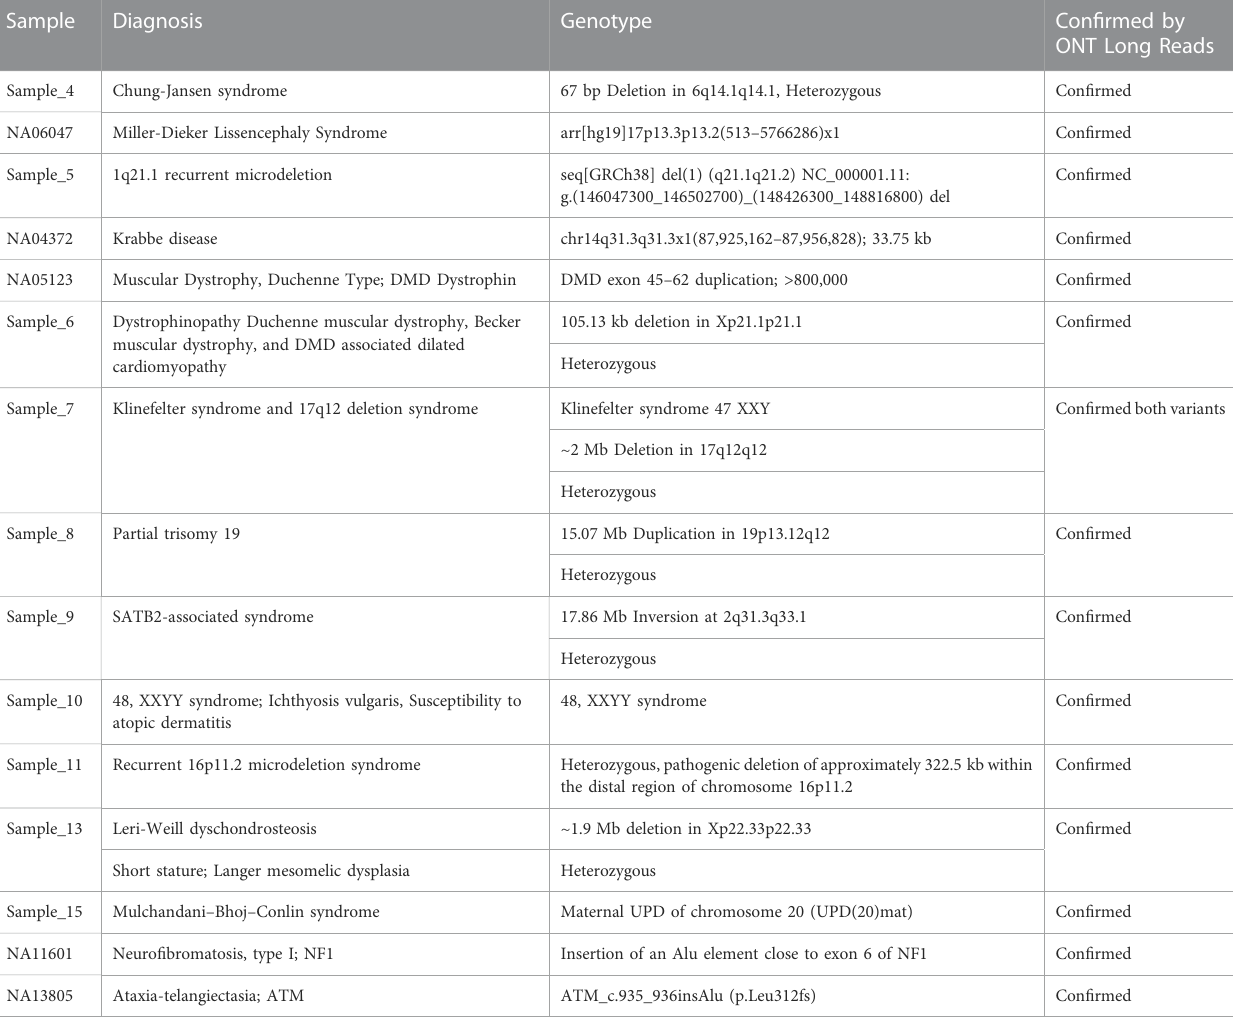
TABLE 4 Clinical validation of pathogenic Structural Variant (SV) detection with long read sequencing.